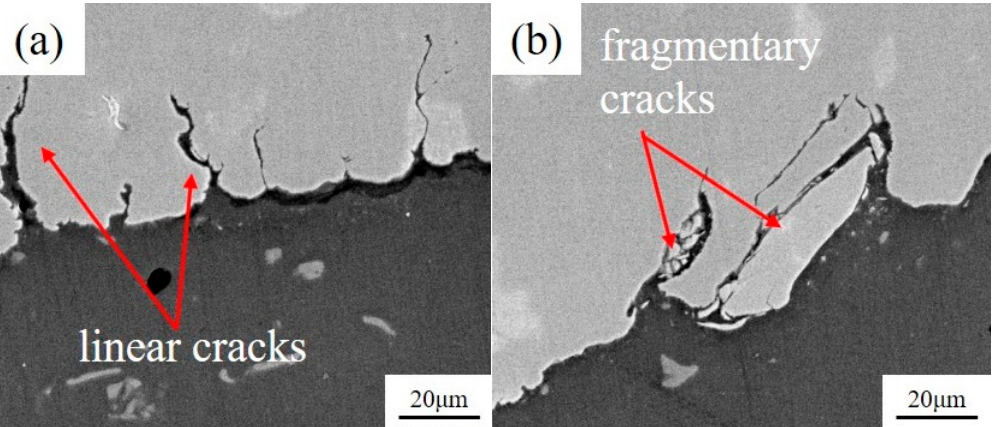
Figure 12. Linear cracks ( a ) and fragmentary cracks ( b ) at the interface of dissimilar Al/steel keyhole- free FSSW